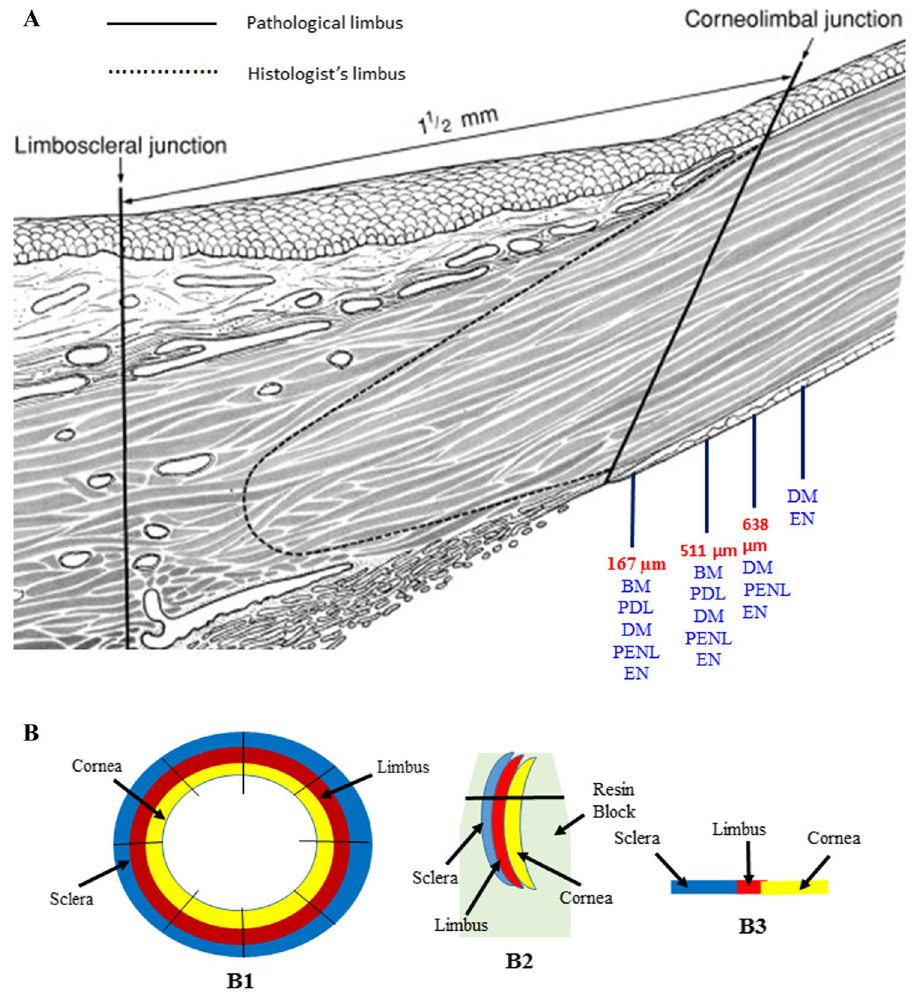
Figure 5. ( A ) A Schematic illustration of the posterior peripheral cornea showing the distribution of the layers according to the distance from the DME. ( B ) A schematic diagram of the corneoscleral rims (Modified from Hogan et al.) 21 . ( B1 ) The corneoscleral rims cut into small pieces to embed in the resin to make blocks. ( B2 ) Block containing the sclera, limbus, and cornea for sectioning. ( B3 ) A semi-thin section from the block containing the sclera, limbus, and cornea. BM basement membrane, BW Bowman’s layer, DM Descemet’s membrane, DME Descemet’s membrane endpoint, EN endothelium, PDL pre-Descemet’s membrane layer, PENL pre-endothelial layer, S stroma, TB trabecular